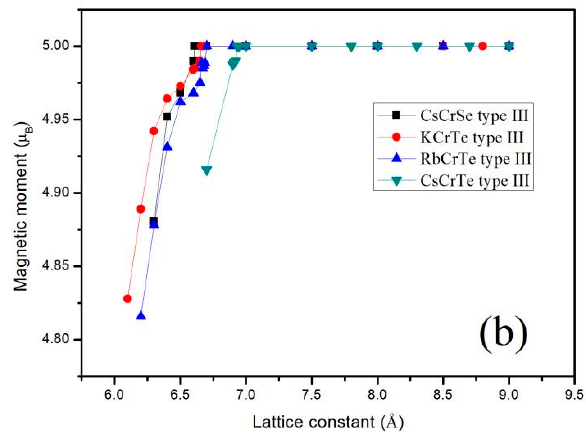
Figure 4. Calculated total magnetic moments as functions of the lattice constant for KCrS, RbCrS, CsCrS, KCrSe, RbCrSe ( a ) and CsCrSe, KCrTe, RbCrTe, CsCrTe ( b ), respectively, with their most stable phase.